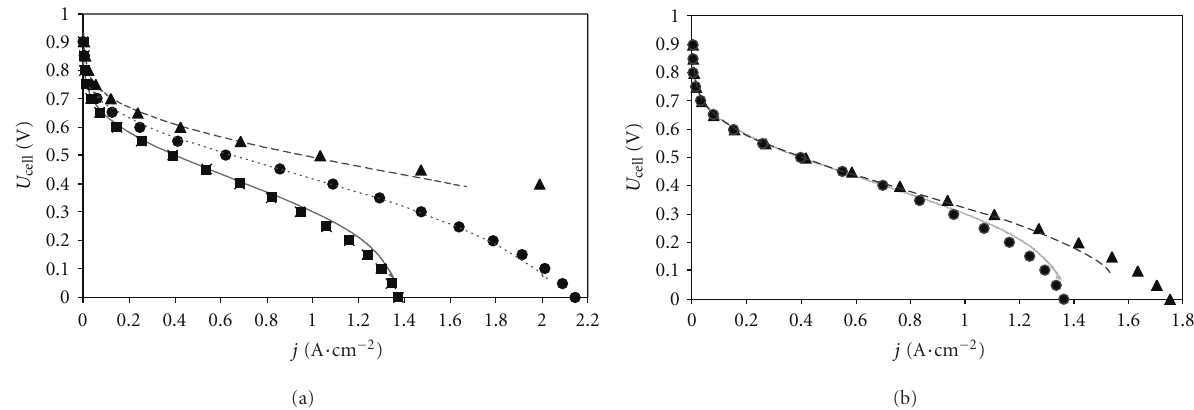
Figure 8: Model prediction from a 2/1D thin film film model of the PBI PEMFC. 50% Pt/C at the cathode and 20% Pt/C at the anode at 150 ◦ C. (a) E ff ect of oxidant gas and at various pressures (i) – Experimental air atmospheric pressure, (ii) (cid:2) model air atmospheric pressure, (iii) ... experimental air 1 bar, (iv) • model air 1bar, (v) – – experimental O 2 atmospheric pressure, and (vi) (cid:3) model O 2 atmospheric pressure. (b) E ff ect of using air or helox as oxidant. (i) – Experimental air, (ii) • model air, (iii) – – experimental helox, and (iv) (cid:3) model helox.